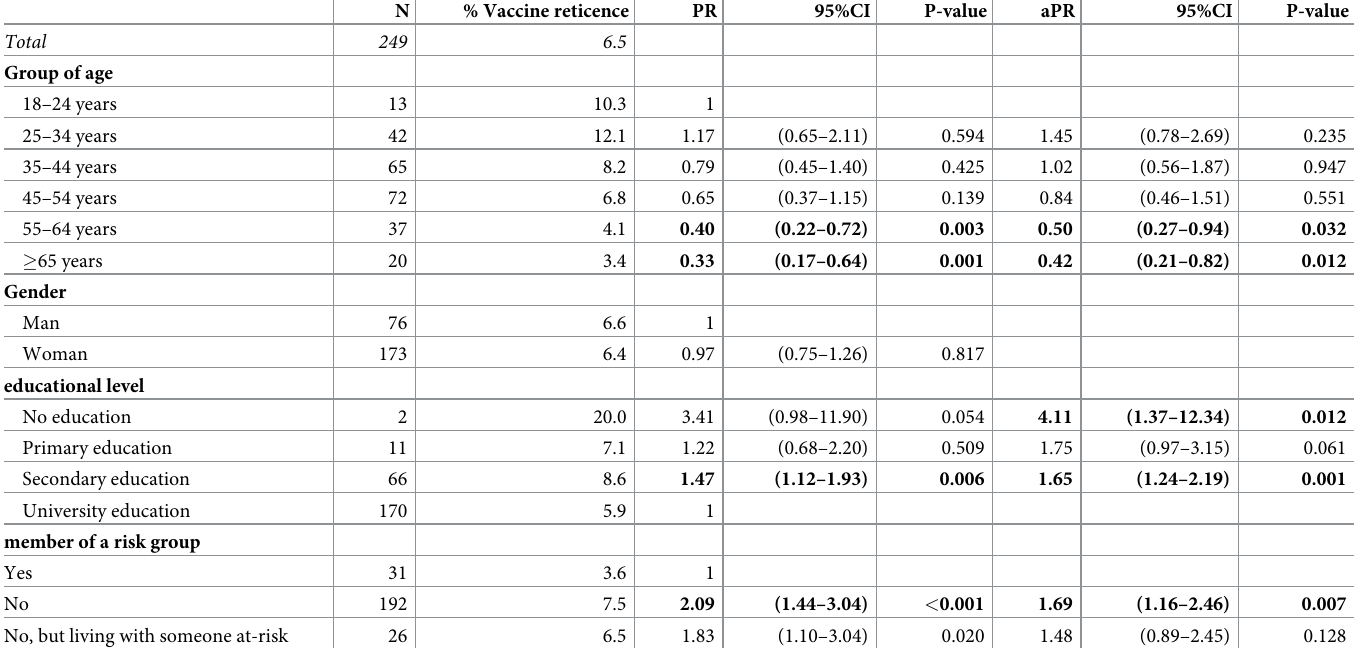
Table 5. Prevalence Ratios (PR) and adjusted Prevalence Ratios (aPR) of COVID-19 vaccine reticence in adults of the general population, estimated used Poisson regression models. N % Vaccine